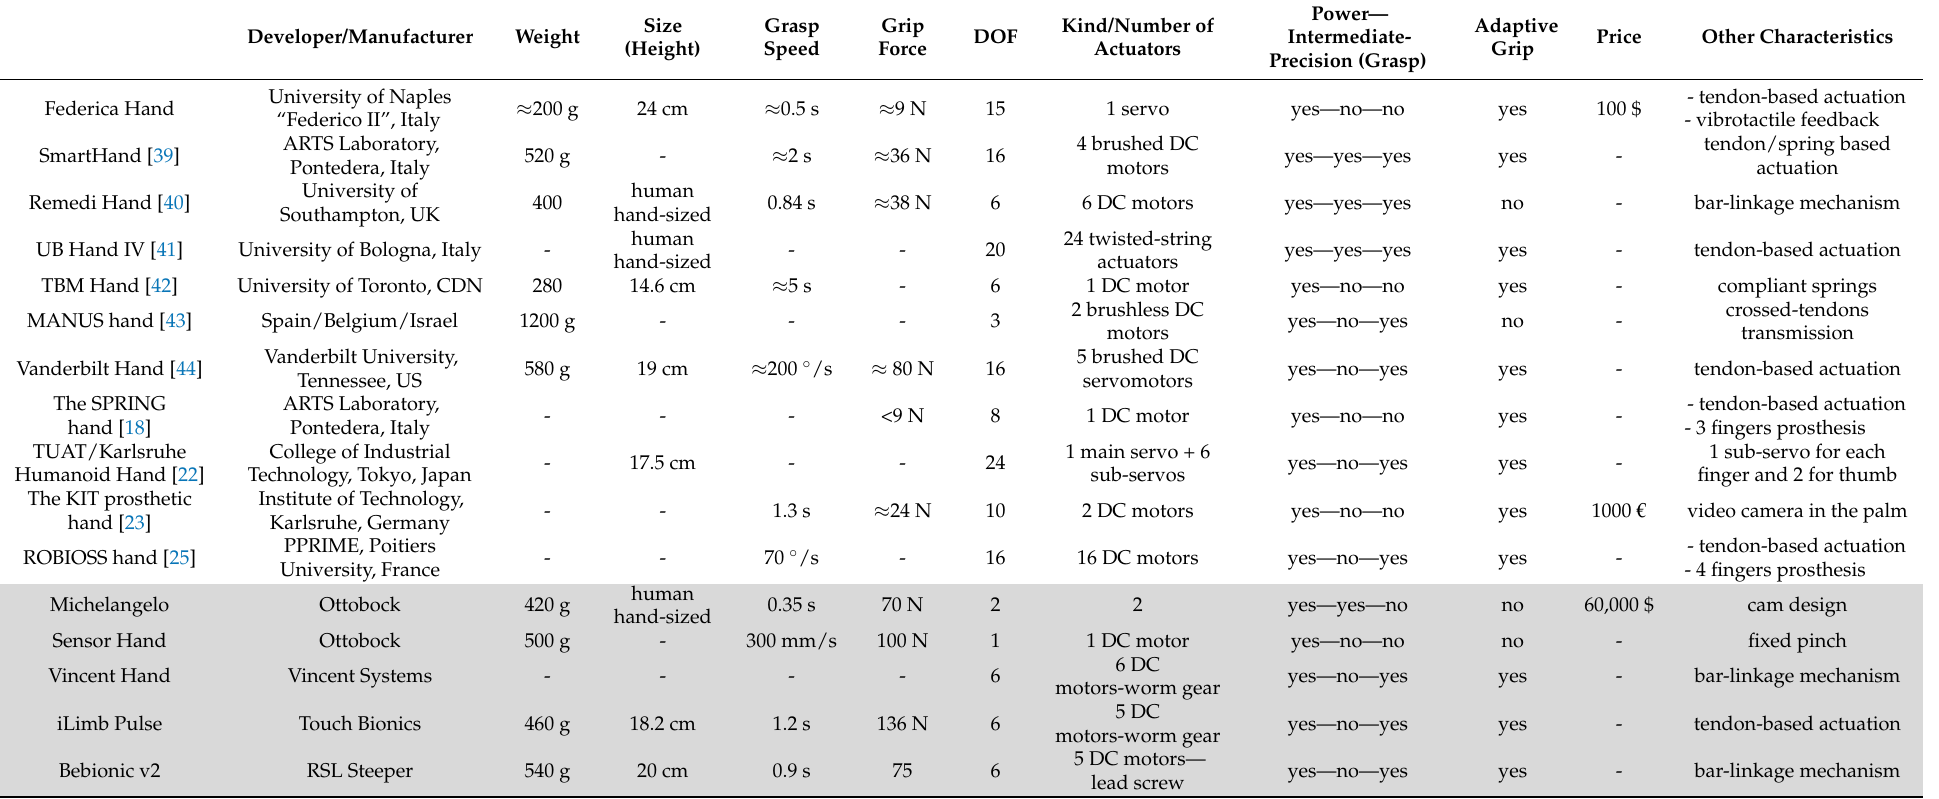
Table 3. Comparison between “Federica” hand and other externally powered hand prostheses (prototypes and commercial devices [34]—highlighted in grey